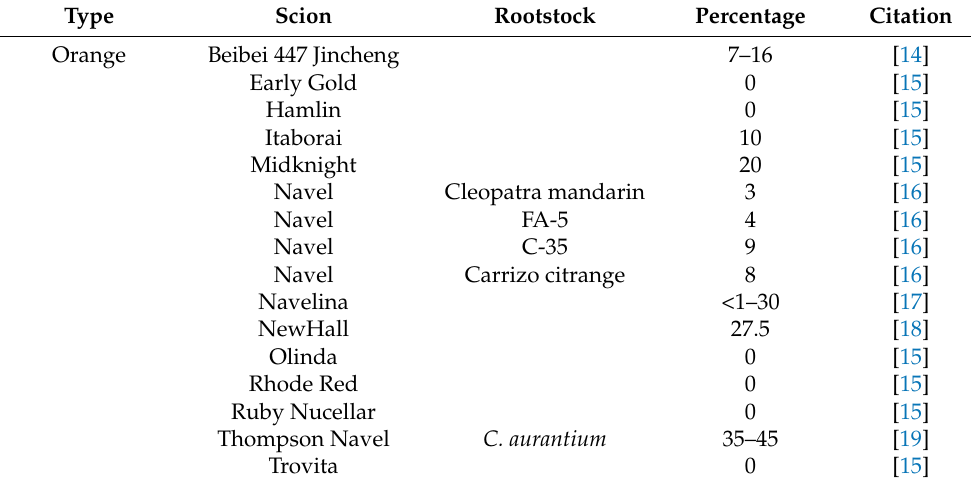
Table 1. Incidence of PFS in citrus fruits. This table only considers the control treatment in the cited manuscripts. Only articles that have incidence of PFS expressed as a percentage were included. Rootstock information was not always published.